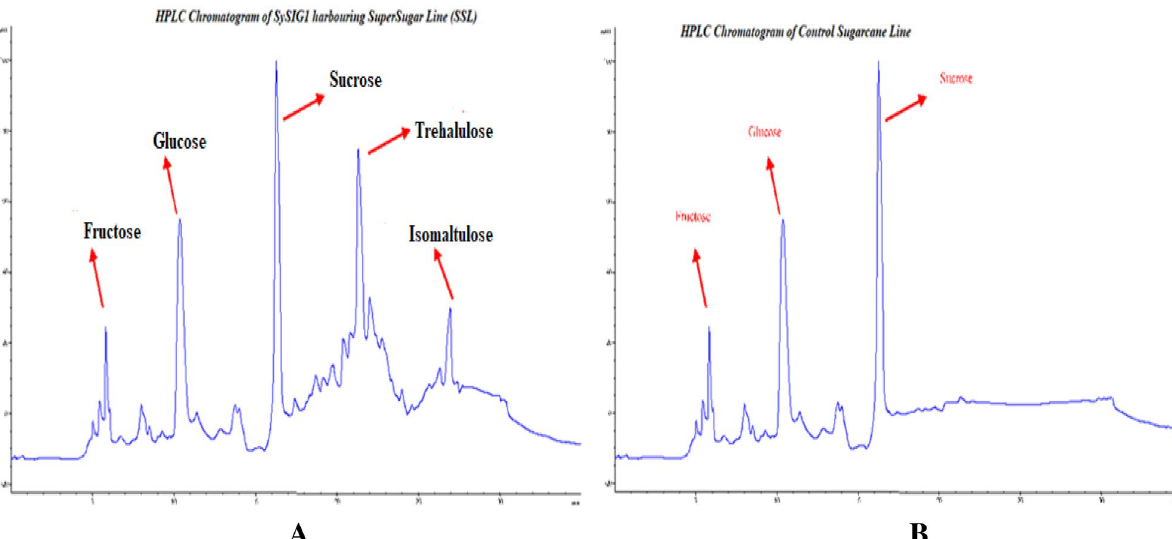
Figure 9. ( A ) The automatic HPLC based quantifications of various sugar contents obtained in different transgenic lines ( B ) HPLC based quantifications of control sugarcane lines employed in this study. Different peaks were shown by red arrows in both ( A , B